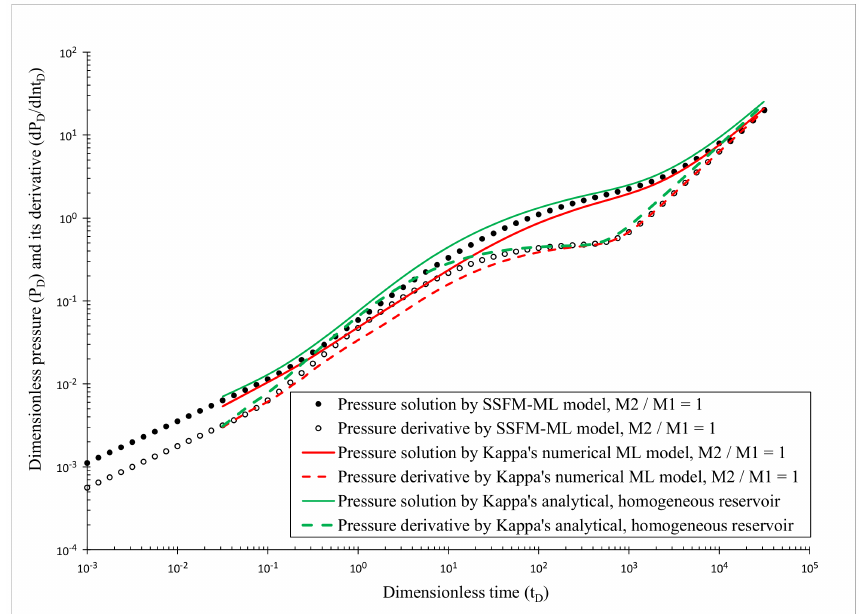
Figure 9. Comparison of SSFM-ML model (black dots) with Kappa’s numerical model (red curves) for a 2-layer reservoir under M 2 /M 1 = 1, with 2 y e 1 D = y e 2 D = 100, h e 1 D = h e 2 D = 50 and C s2 /C s1 = 1. Additionally, solutions of a homogeneous reservoir with MHFHW are also provided from Kappa’s analytical model (green curves). The three cases have the same reservoir-well system geometry and reservoir